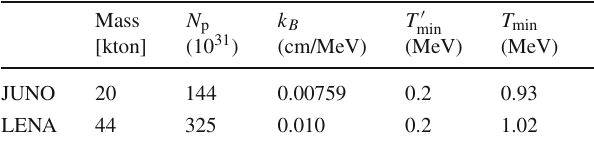
Table 2 Numbers of IBD and NC events in three specific scenarios listed in Table 1 for different sets of the average mean energies (< >, < E ¯ ν >, < E ν >) at JUNO E ν e e x